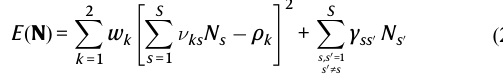
^ N (red cross in Fig. 5) to the average abun- We fi t its minimiser dances (cyan cross in Fig. 5) for the last cycle of the most stable time series (Fig. 14c in ref. 36 ); see also Supplementary Notes, Supplemen- tary Fig. 9, and Supplementary Table 3. These average abundances anchor our comparison between the experimental data and the DFTe ^ N Þ + Δ E , with a suitably chosen ‘ excitation ’ energy Δ E . As trajectory H ð expected, amensalistic interactions are not supported by the data and are therefore ruled out, see Supplementary Fig. 8 and Supplementary Fig. 10. By comparing, for example, the energies in Eqs. (29) and (30) for the grasses and the microbial predator – prey system, respectively, we see that DFTe is capable of determining what (very) different sys- tems share — in this case the parasitic interaction, but not the dispersal